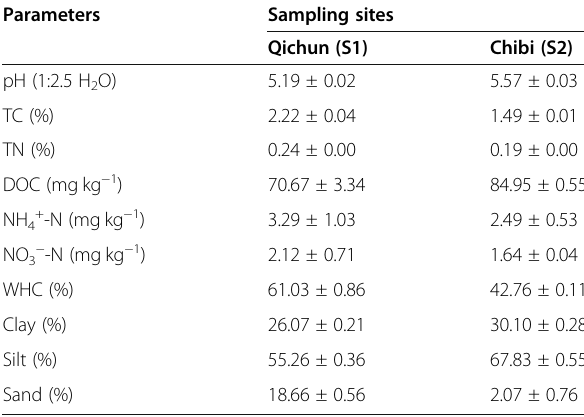
Table 1 Selected characteristics of the two paddy soils prior